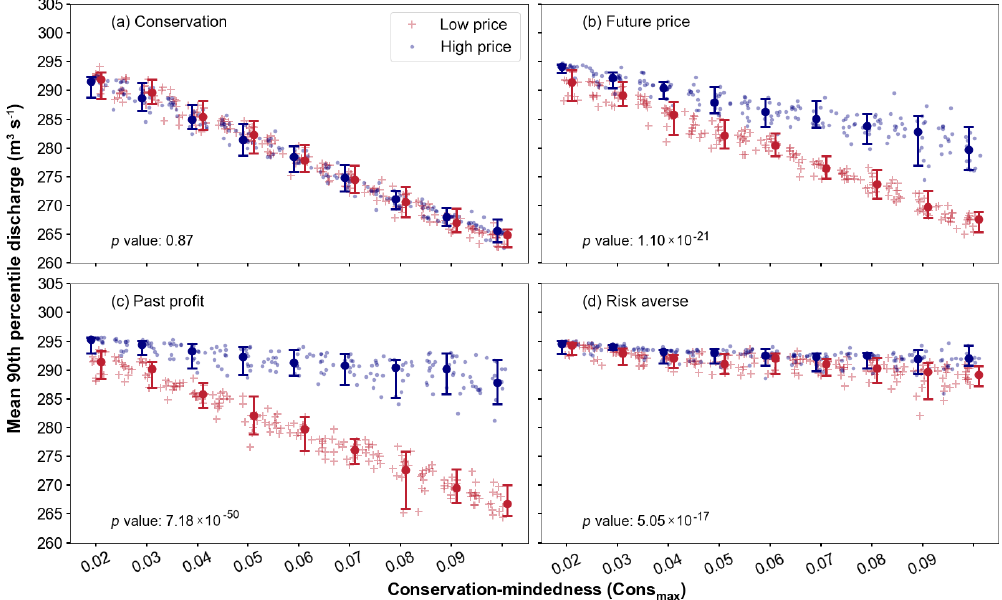
Figure 7. Mean 90th percentile discharge for high and low crop price scenarios with (a) 80% weight on conservation goal, (b) 80% weight on future price, (c) 80% weight on past profit, and (d) 80% weight on risk aversion. The circles indicate the median values and the bars show the 5th and 95th percentiles of discharge for all simulations at a specific Cons max .